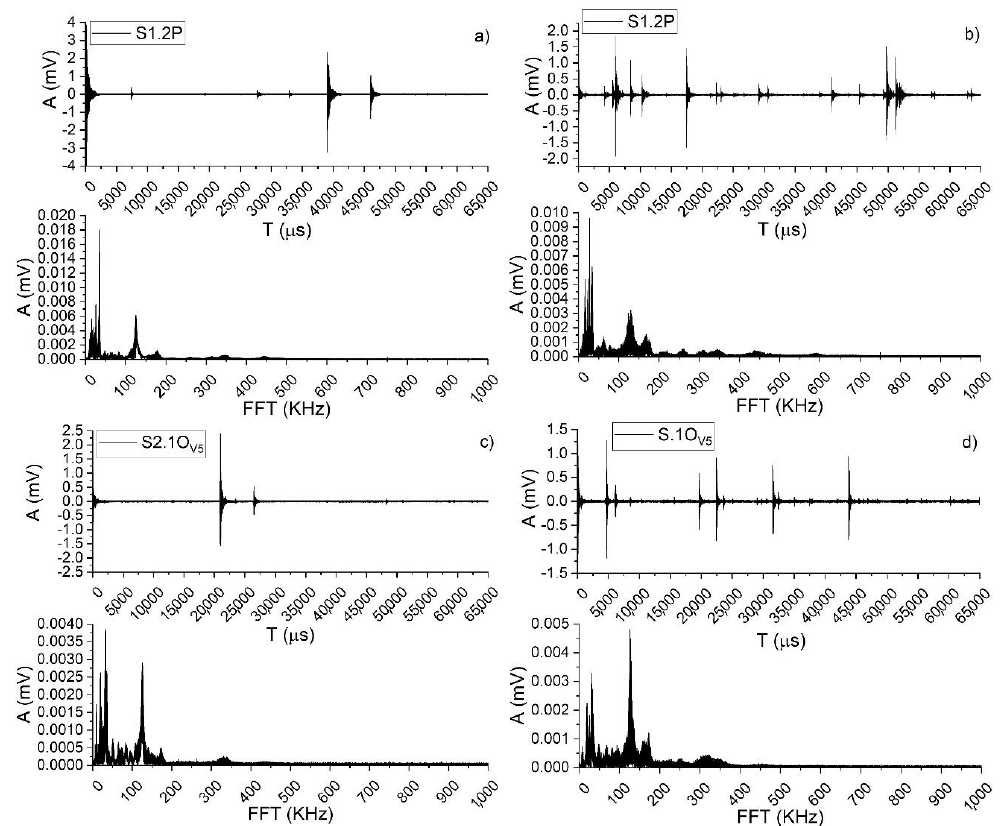
Figure 5. Frequency characteristics of AE features from samples S1.2P ( a , b ) and S2.1O V5 ( c , d ). ( a ) Top, waveform of a signal collected during the brittle state on S1.2P and bottom, FFT of the above AE signal; ( b ) Top, waveform of a signal collected during the ductile state on S1.2P and bottom, FFT of the above AE signal; ( c ) Top, waveform of a signal collected during the brittle state on S2.1O V5 and bottom, FFT of the above AE signal; ( d ) Top, waveform of a signal collected during the ductile state on S2.1O V5 and bottom, FFT of the above AE signal.